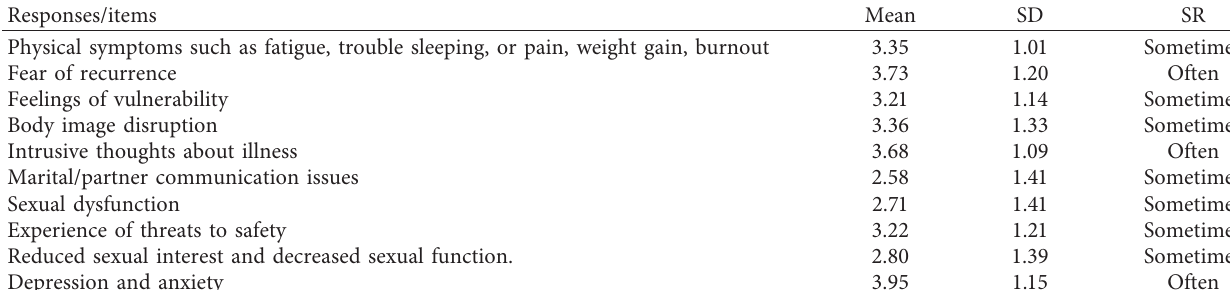
Table 2: Experience of challenges among women diagnosed with breast